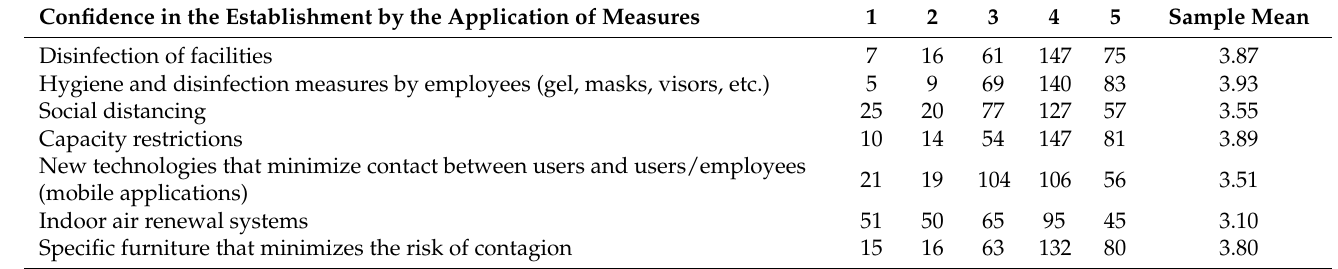
Table 3. Level of confidence generated by the measures implemented (in number of